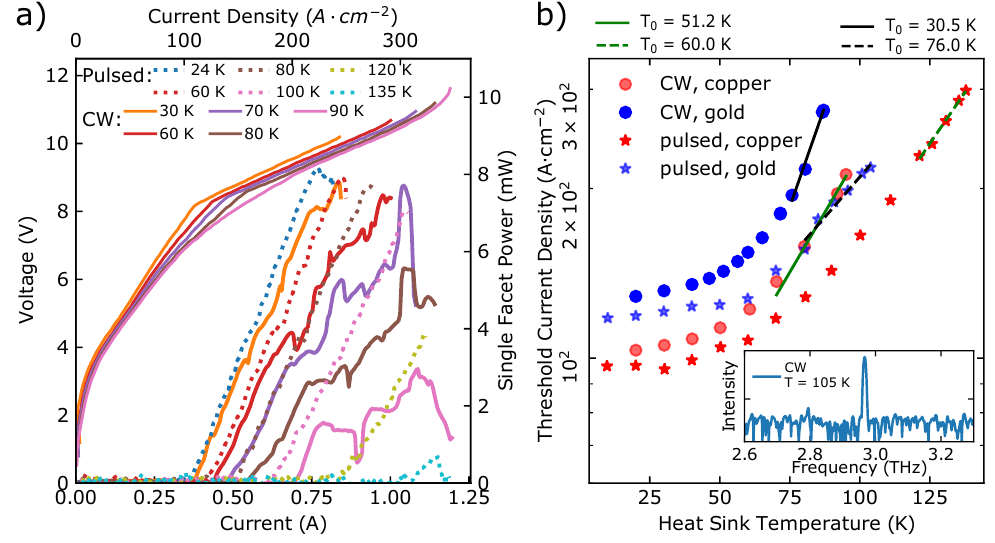
Figure 1. ( a ) LIV Pulsed (2 % duty cycle at 132 kHz repetition rate) and CW of a 4 mm long and 86 µ m wide device. For visibility, only CW IV curves are presented. Pulsed power is detected by the Absolut THz Power Meter by Thomas Keating Ltd and in CW by the 3A-P-THz by Ophir . CW power is corrected for collection losses and atmospheric absorption in the setup to be compared with the pulsed measurements. ( b ) Threshold Current Density vs Temperature of a 4 mm long and 64 µ m wide Cu–Cu device and a 1.45 mm long and 65 µ m wide Au-Au device. Inset: Increased CW performance of the same Cu–Cu device up to 105 K before having nickel evaporated on the top contact setback, i.e., having